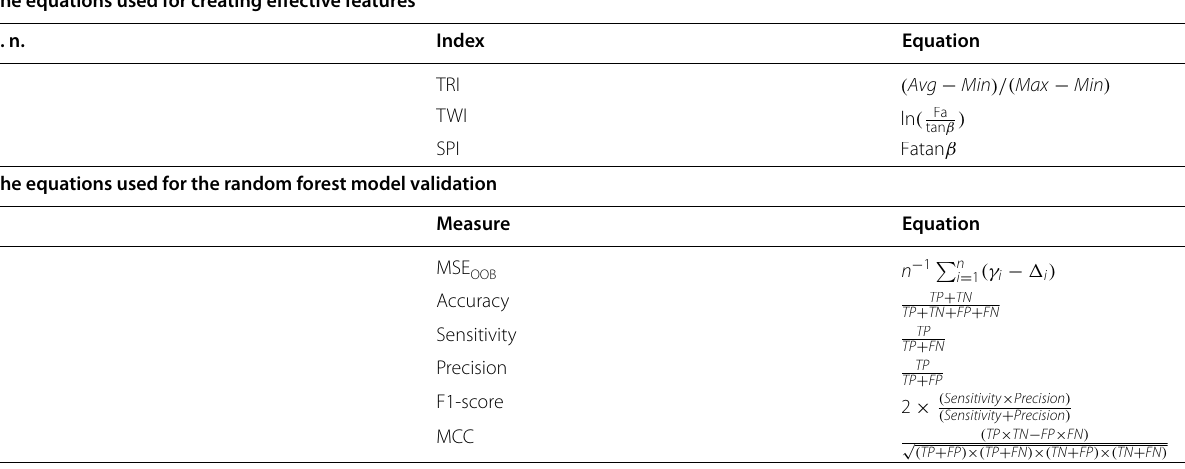
Table 2 The equations used to create some effective features (TRI, TWI and SPI) associated with the equations used for random forest model